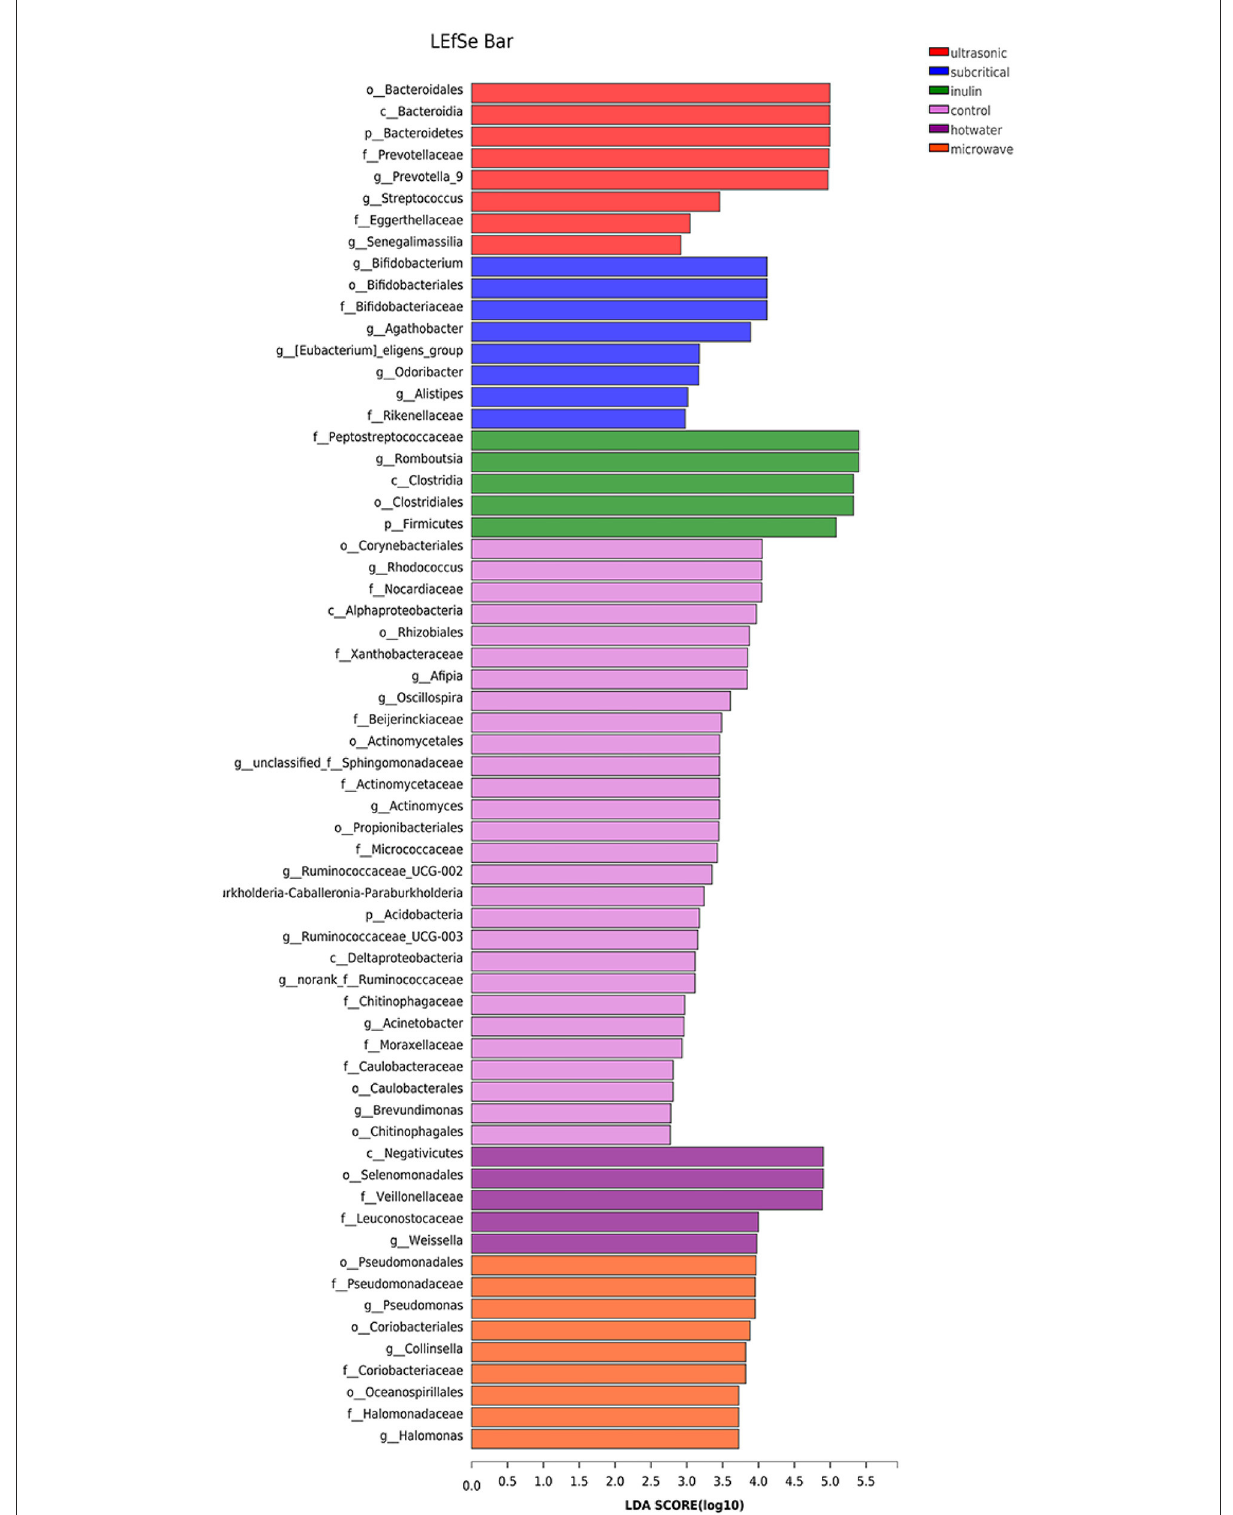
FIGURE6 Bacterial taxa identified as differentially abundant between groups according to linear discriminant analysis effect size (LEfSe) ( n = 5). Control stands for blank control group. The hot water, ultrasonic, subcritical, and microwave stand for dietary fiber extracted with hot water, ultrasonic assisted, subcritical water, and microwave assisted methods,